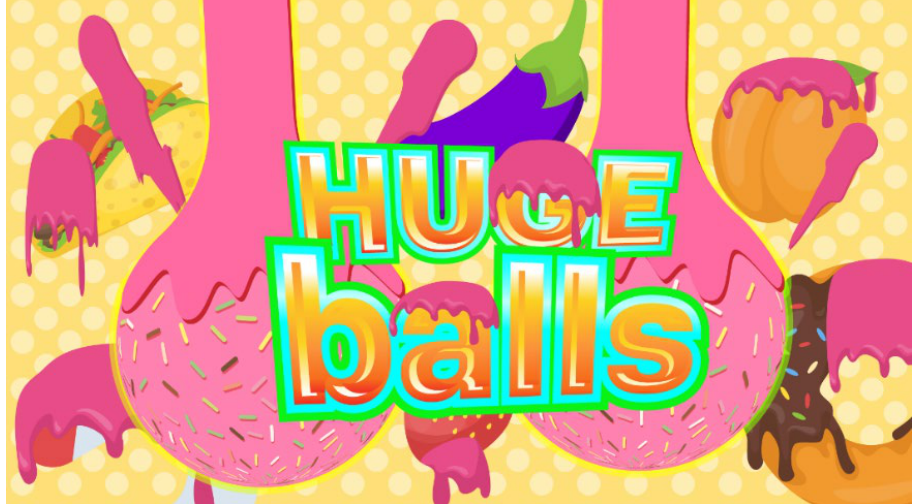
Figure 3. The visual elements inside Huge